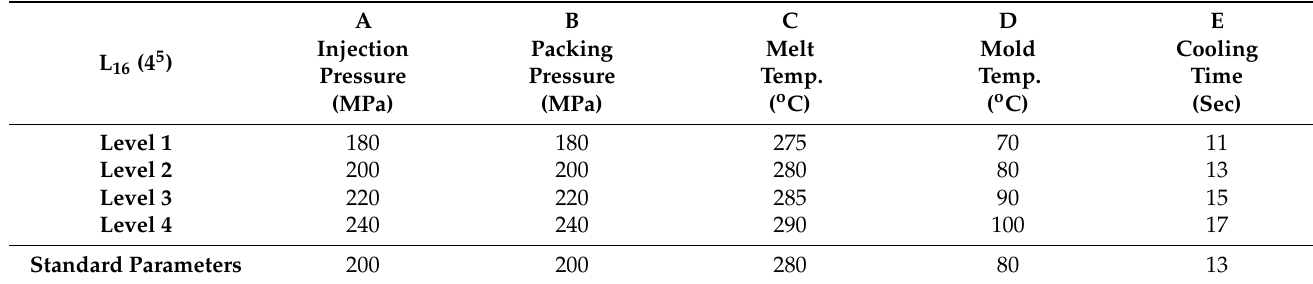
Table 2. Control factors and level settings used in Taguchi simulations.